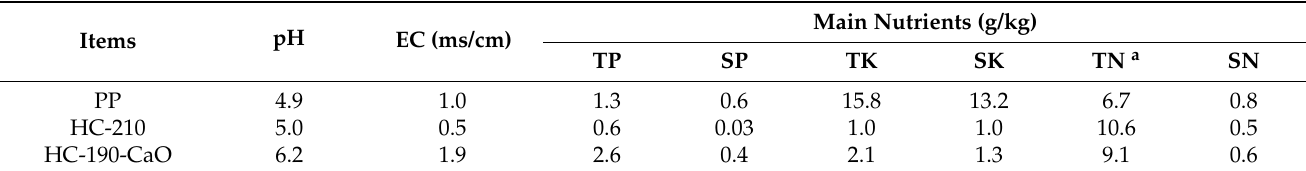
Table 2. The pH, EC, and main nutrients of raw PP and HC